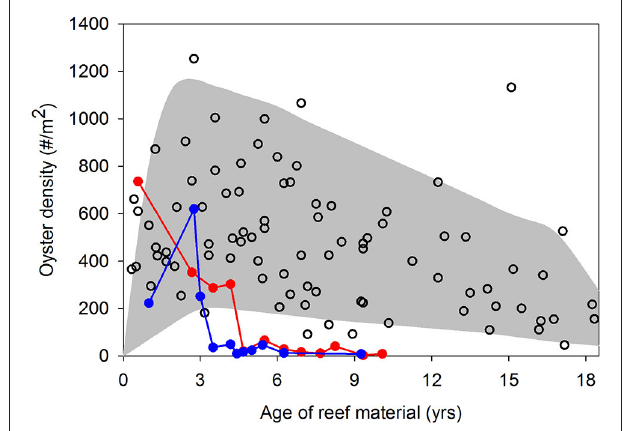
FIGURE 1 | Mean oyster density as a function of age of restored reefs in 10 oyster sanctuaries sampled by the North Carolina Division of Marine Fisheries from 2007 to 2014 (NC DMF, unpublished data). The filled area provides general maximum and minimum density trends across reef ages and open circles are actual observations. Closed circle lines represent two instances where oyster densities in sanctuaries collapsed. See Figure 2 (closed squares) for sanctuary locations in Pamlico Sound, NC